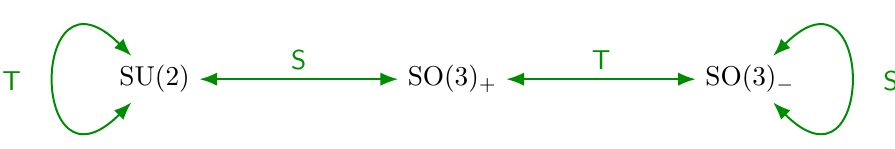
Figure 4 . Modular transformations for theories with gauge algebra su (2) , with background gauge fields for the one-form symmetry turned